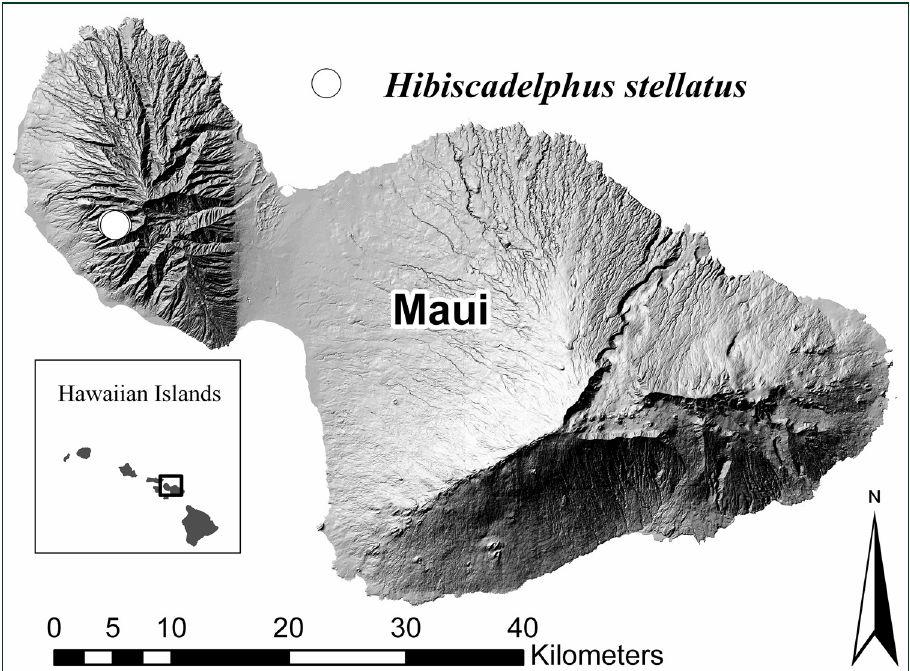
Figure 3. Distribution map showing known locations of Hibiscadelphus stellatus on West